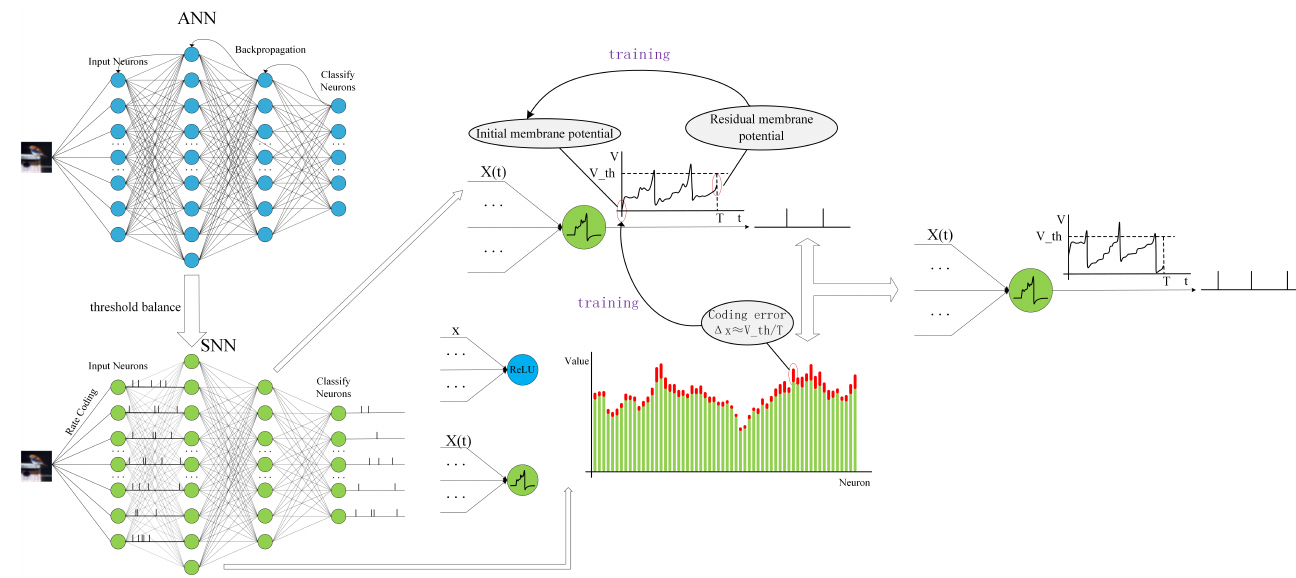
Figure 4. Network structure diagram of the SNN with Initialized Membrane Potential and Coding Compensation